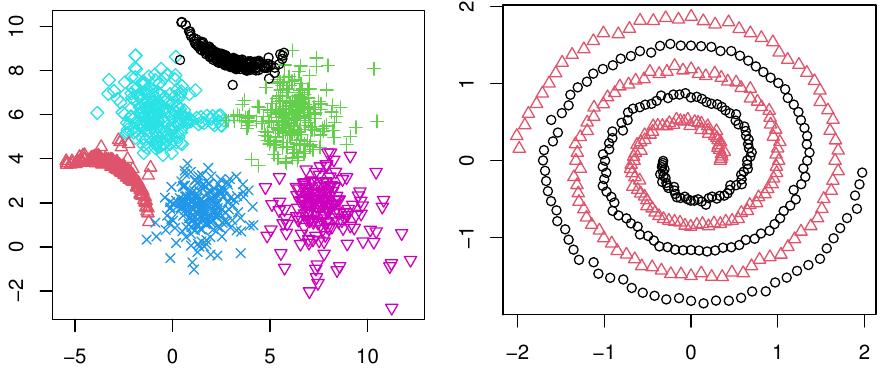
Figure 2. Simulated bivariate data sets, colors, and shapes represent the partition obtained with spectral